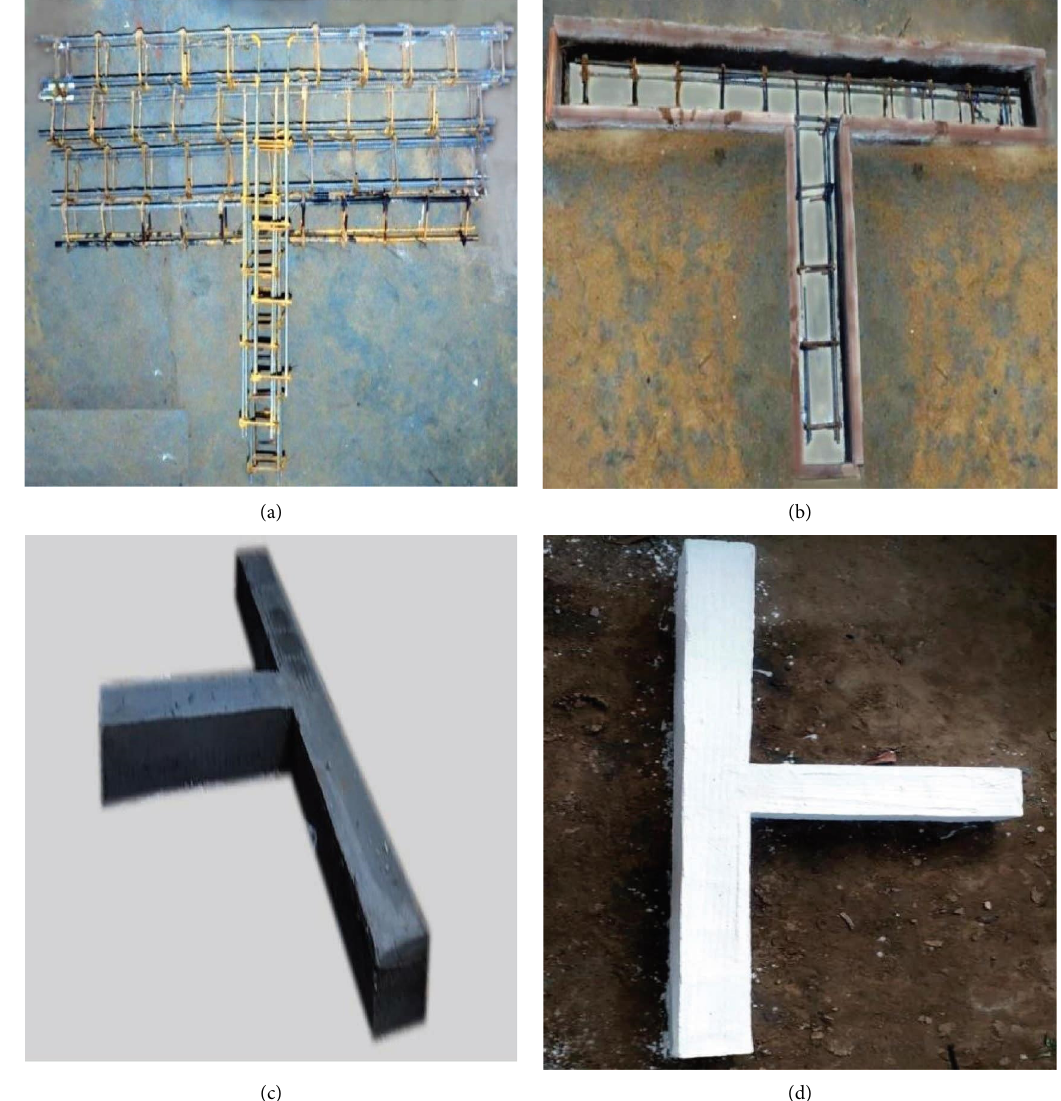
Figure 3: Preparations of test specimen: (a) steel reinforcement cages, (b) wood fag and steel reinforcement cages, (c) casted specimen, and (d) white washing